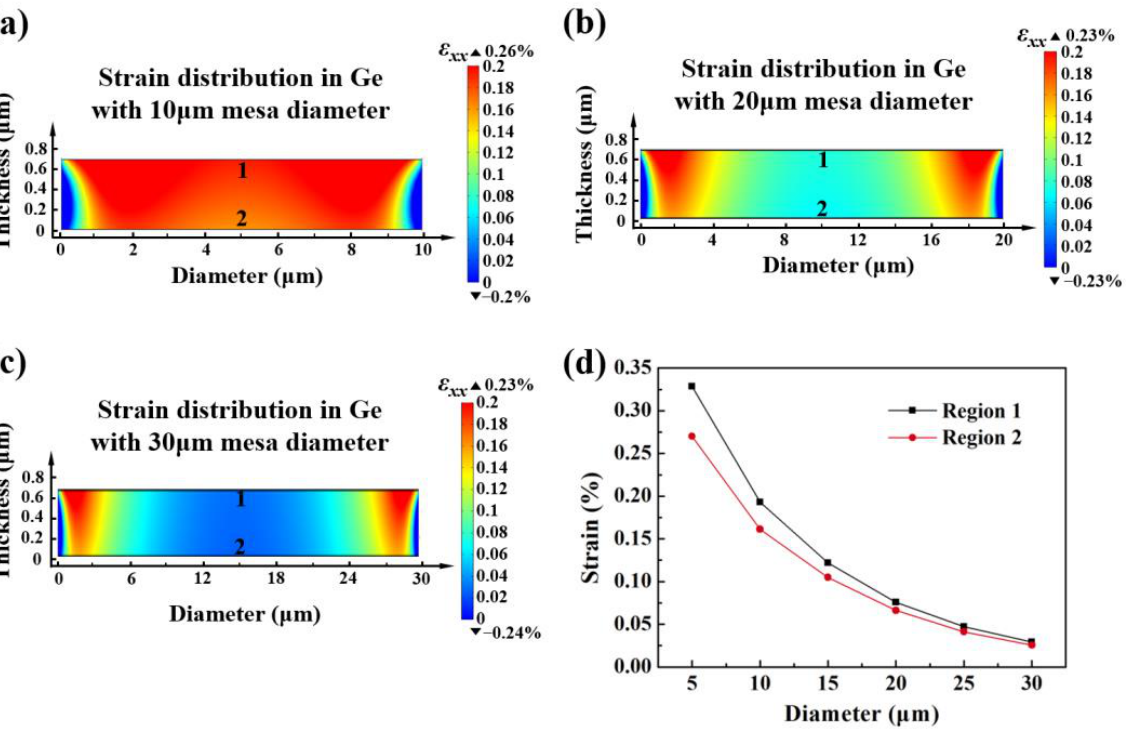
Figure 3. The strain profiles in Ge with ( a ) 10 µm mesa diameter and ( b ) 20 µm mesa diameters and ( c ) 30 µm mesa diameter. ( d ) The value of introduced strain in region 1 – 2 with various mesa diameters.